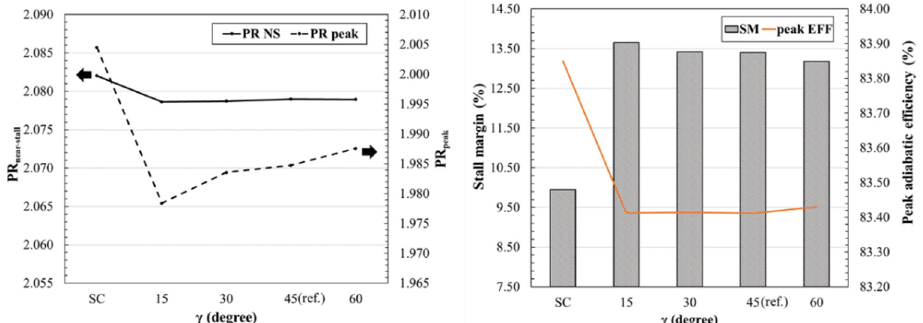
Figure 13. Effects of middle bleed angle on performance.